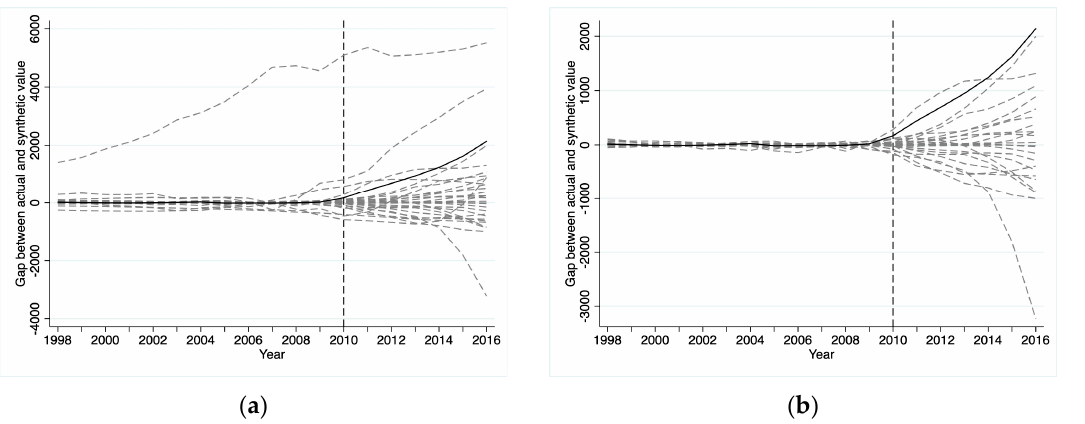
Figure 7. Distribution of prediction gaps: ( a ) Chongqing and other areas; ( b ) Chongqing and the valid fitting provinces.